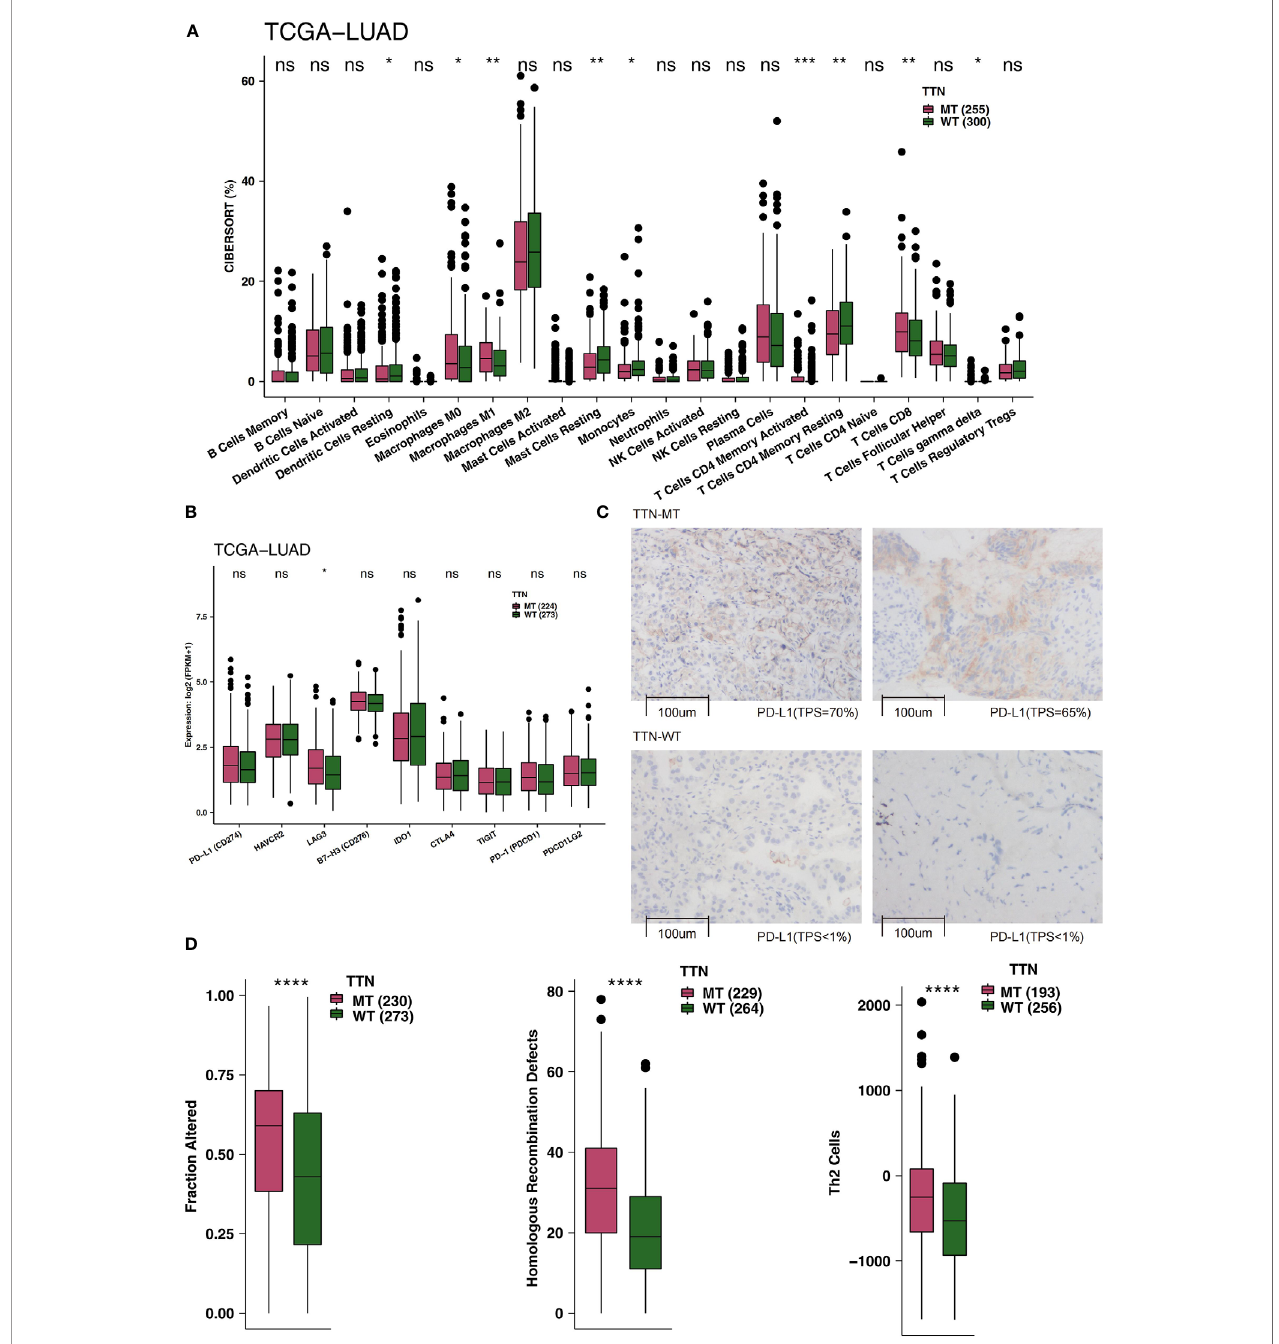
FIGURE 3 | An association of TTN status and immune in fi ltration in the LUAD patients. (A) Comparison of 22 immune cells between TTN-MT and TTN-WT tumors in the TCGA-LUAD cohort. (B) Comparison of immune checkpoint molecules between TTN-MT and TTN-WT tumors in the TCGA-LUAD cohort. (C) The typical cases for each TPS level between the TTN-MT (two samples; high PD-L1 TPS) and TTN-WT (o samples; no PD-L1 TPS) groups in the Local-LUAD. Using HE- and PD-L1-stained slides, we manually assessed the number of tumor cells, the sample size (diameter), the crush rate with a cutoff value of <1% (no PD-L1 TPS), 1 – 50% (low PD-L1 TPS), 50%< (high PD-L1 TPS), and the TPS for each biopsy sample using the slide that contained the most tumor cells. The TPS level was evaluated by pathologists who completed training courses in TPS estimation. (D) Comparison of immune-related scores between TTN-MT and TTN-WT tumors in the TCGA- LUAD cohort. *P < 0.05; **P < 0.01; ***P < 0.001; ****P < 0.0001, ns, not signi fi